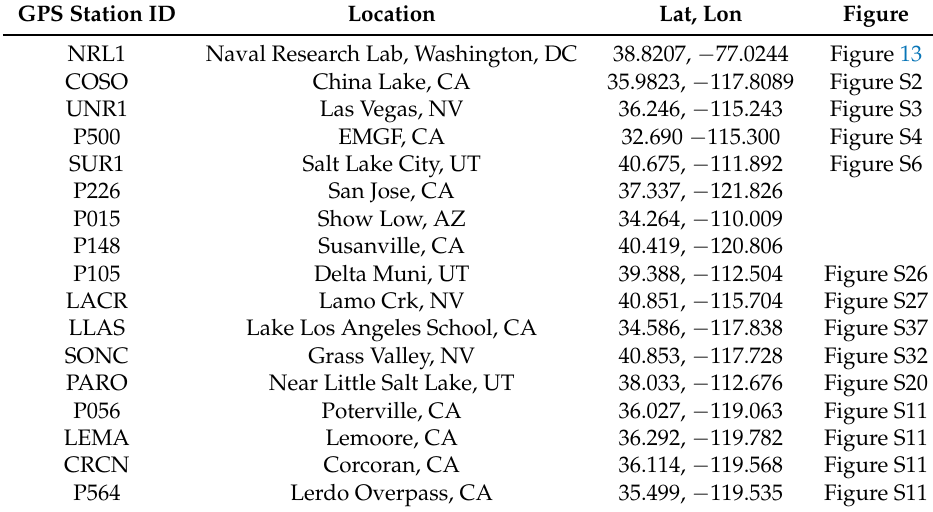
anthropogenic deformation identified in this